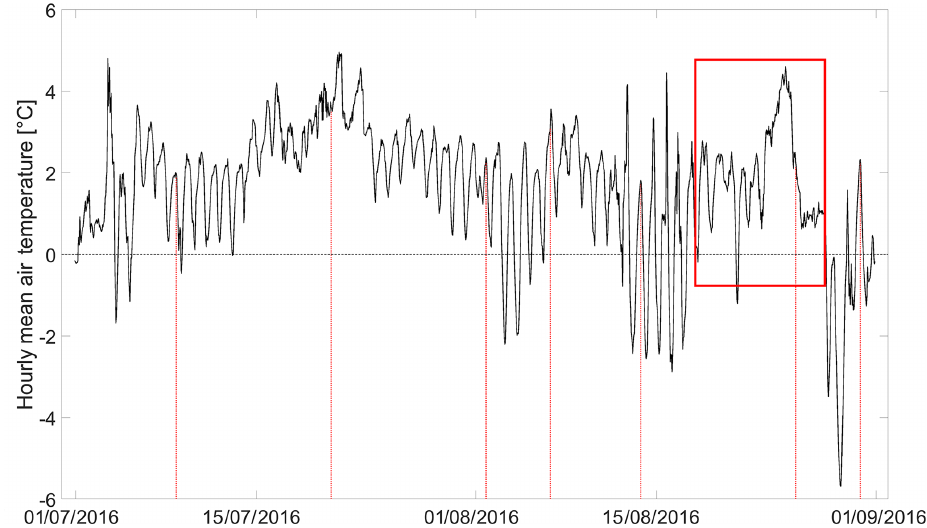
Figure A1. Hourly mean temperatures in degrees Celsius for GCNet station JAR1 (69 ◦ 29 (cid:48) 42 (cid:48)(cid:48) N, 49 ◦ 42 (cid:48) 14 (cid:48)(cid:48) W, 932ma.s.l.; Steffen et al., 1996) in black, the satellite acquisition times are shown in red. The warm period starting on 21 until 28 August is highlighted by the red rectangle.